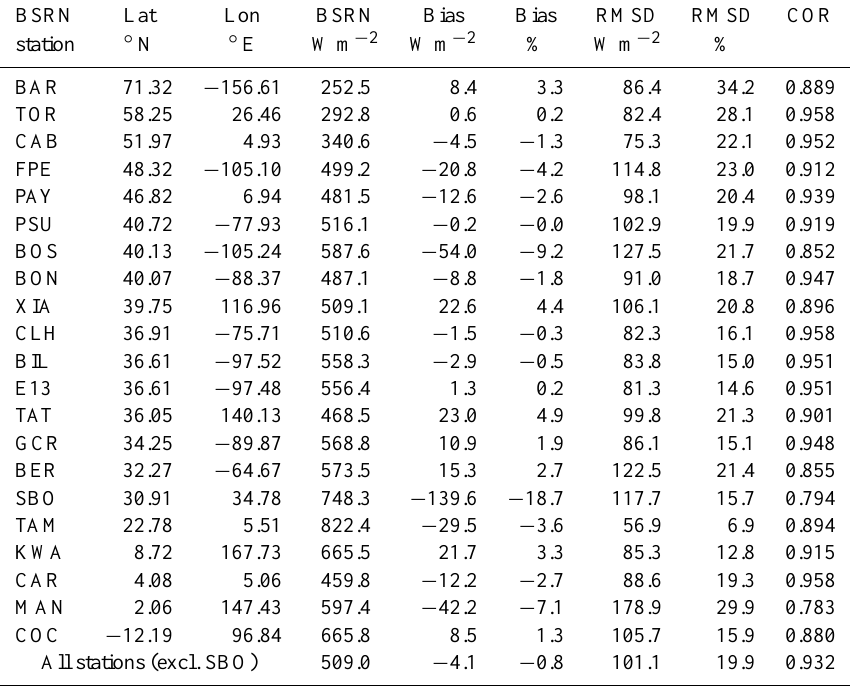
Table 1. Instantaneous SCIAMACHY SSI evaluation results using the BSRN global irradiances in 2008. Column 4: BSRN Wm − 2 is the mean BSRN data used for validation at every station, the average of the BSRN data used in Figs. 5 and 6. Bias=SCIAMACHY SSI–BSRN, RMSD=root mean square deviation, COR=correlation.